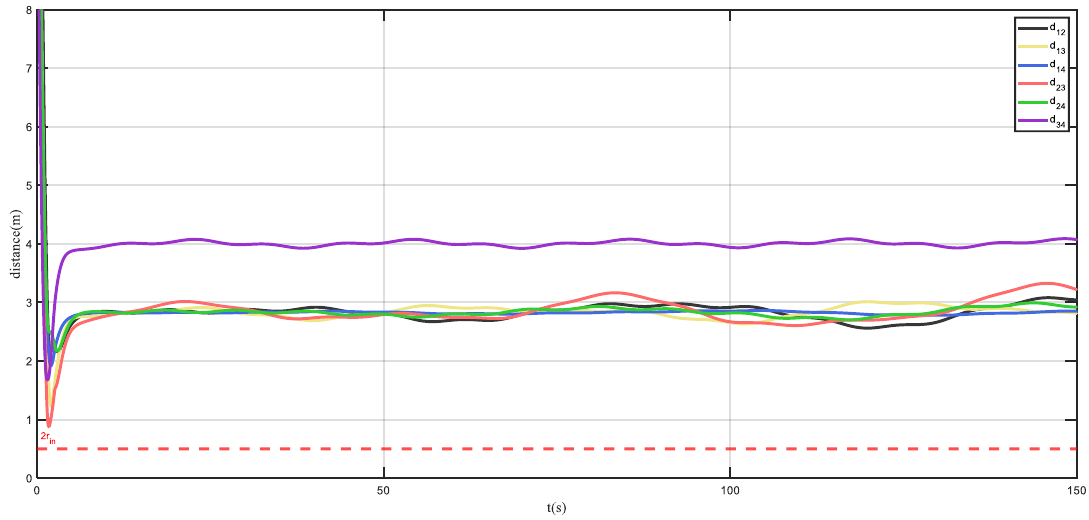
Figure 6. Three-dimensional (3D) trajectory of the UUV formation with collision avoidance under unknown disturbance.